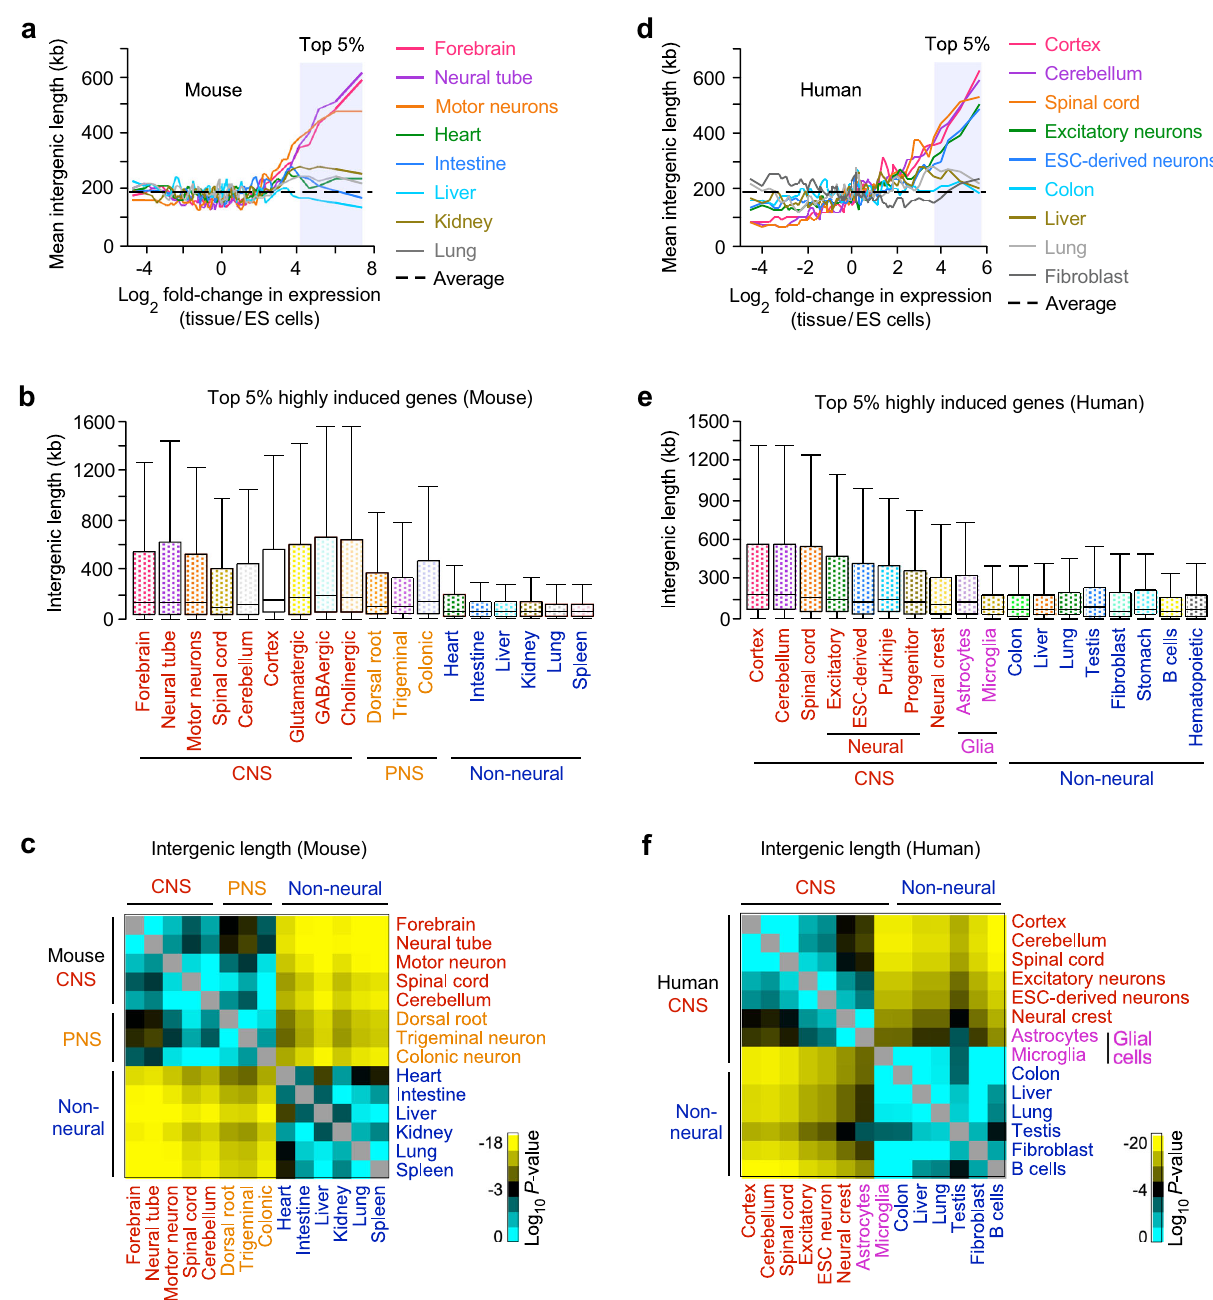
Fig. 1 Genes highly induced in neurons and neural tissues have signi fi cantly extended intergenic DNA. a Genome-wide relationship between intergenic DNA lengths and gene induction levels, assessed by RNA-seq analysis of postnatal (0 day or P0) mouse tissues (forebrain, heart, intestine, liver, kidney, lung), embryonic (E15.5) neural tube, and ES cell-derived motor neurons (Supplementary Data 1). The lines represent the mean intergenic lengths for genes, binned according to the gene induction level for each tissue compared to ES cells (log 2 fold-change in FPKM: fragments per kilobase of transcript per million reads, 200 genes per bin, 18,383 mRNA genes). The dotted line indicates the average intergenic lengths of all the mRNA genes (192.3kb). b Box plots of the intergenic DNA lengths of the top 5% of all the mRNA genes, highly induced in the mouse CNS, PNS, and other tissues (919 genes, Supplementary Data 2), shown in the shaded area in ( a ). Dorsal root, trigeminal, and colonic neurons represent sensory neurons in the PNS. The box plots show the median (line in a box), fi rst-to-third quartiles (boxes), and 1.5 × the interquartile range (whiskers). c Heatmap of the P -value (two-sided, two- sample t -test) for the difference in intergenic lengths of the top 5% of all the mRNA genes, highly induced in each tissue (919 genes) between pairwise combinations of the representative tissues shown in ( b ) (Supplementary Data 3). P -values were not adjusted for multiple comparisons. Yellow represents signi fi cant P -values, and black and cyan represent less or non-signi fi cant P -values. d Same analyses as shown in ( a ) except human tissues and cells. The lines represent the mean intergenic lengths for genes, binned according to the gene induction level for each tissue compared to ES cells (200 genes per bin, 19,268 mRNA genes, Supplementary Data 4). The dotted line indicates the average intergenic lengths of all the mRNA genes (197.3kb). e , f Same analyses as shown in ( b , c ) except human tissues and cells, reported in Supplementary Data 1. The top 5% highly induced genes in each tissue and cell type (963 genes), out of all the mRNA genes, were used for the